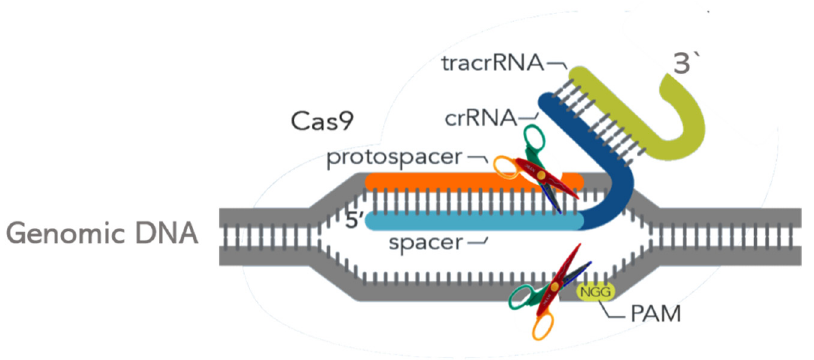
Figure 2. Schematic representation of CRISPR Cas9 modus operandi . crRNA: CRISPR RNA (dark- blue strip); tracrRNA: transactivating crRNA (green strip); PAM: protospacer adjacent motif; Grey strip: genomic DNA; Light-blue strip: spacer; Orange strip: protospacer; Scissors: Cas executor nuclease. Adapted from